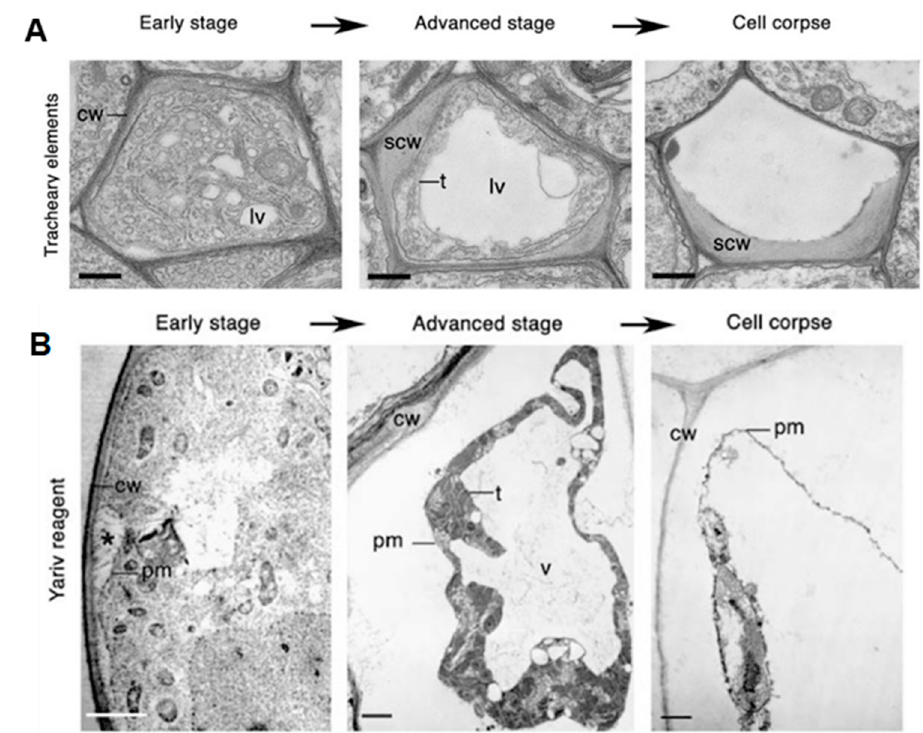
Figure 1. Classes of cell death. ( A ) Vacuolar cell death. Electron micrographs of programed cell death (PCD) in Arabidopsis tracheary elements. cw, cell wall; lv, lytic vacuole; n, nucleus; scw, secondary cell wall; t, tonoplast. Scale bars, 500 nm (tracheary elements). Manifests by a gradual decrease in cytoplasm volume and an increase in lytic vacuole volume. ( B ) Necrotic cell death. Electron micrographs of Yariv-reagent-induced death in the Arabidopsis cell culture. Asterisks denote the detachment of plasma membrane form the cell wall during early stages of cell death. c, chloroplast; cw, cell wall; pm, plasma membrane; t, tonoplast; v, vacuole. Scale bars, 2 µm. There is an absence of a growing lytic vacuole, and there is early rupture of the plasma membrane, which results in shrinkage of the protoplast. Pictures of Arabidopsis treachery elements were republished with authors’ permission from Avci, U.; Petzold, E.; Ismail, I.O.; Beers, E.P.; Haigler, C.H. Cysteine proteases XCP1 and XCP2 aid micro-autolysis within the intact central vacuole during xylogenesis in Arabidopsis roots. Plant J. 2008, 56, 303–315, https://doi.org/10.1111/j.1365-313X.2008.03592.x [21] and those of the Yariv-reagent-induced cell death were republished with authors’ permission from Gao, M.; Showalter, A.M.; Yariv reagent treatment induces PCD in Arabidopsis cell cultures and implicates arabinogalactan protein involvement. Plant J. 1999, 19, 321–331, https://doi.org/10.1046/j.1365-313X.1999.00544.x [22].